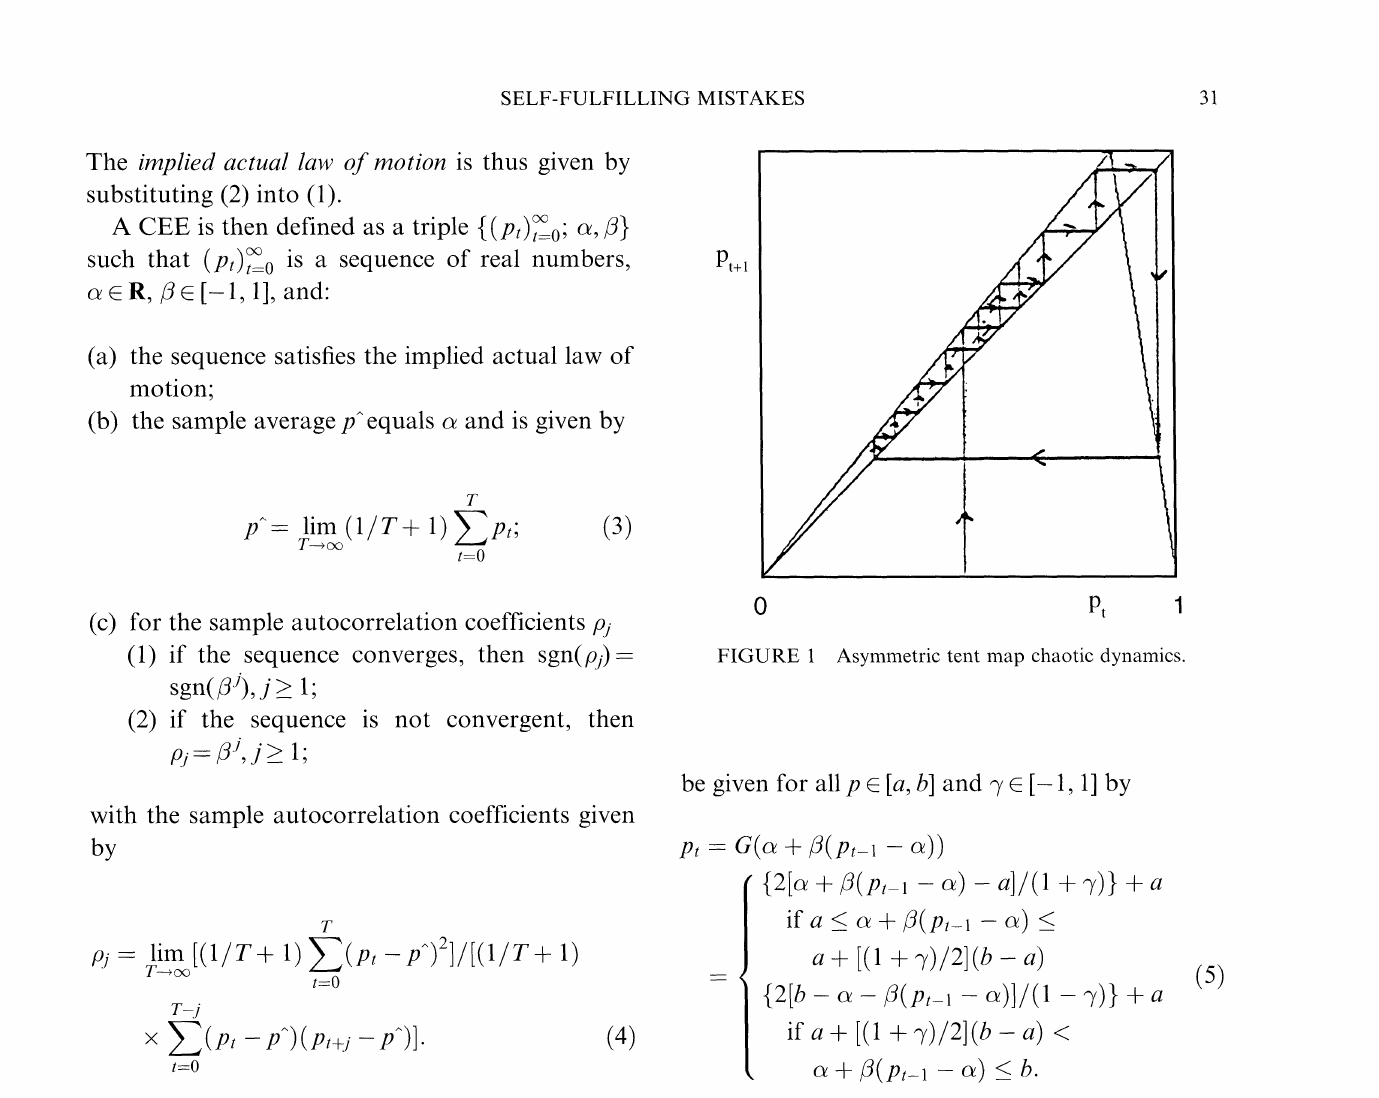
FIGURE Asymmetric tent map chaotic